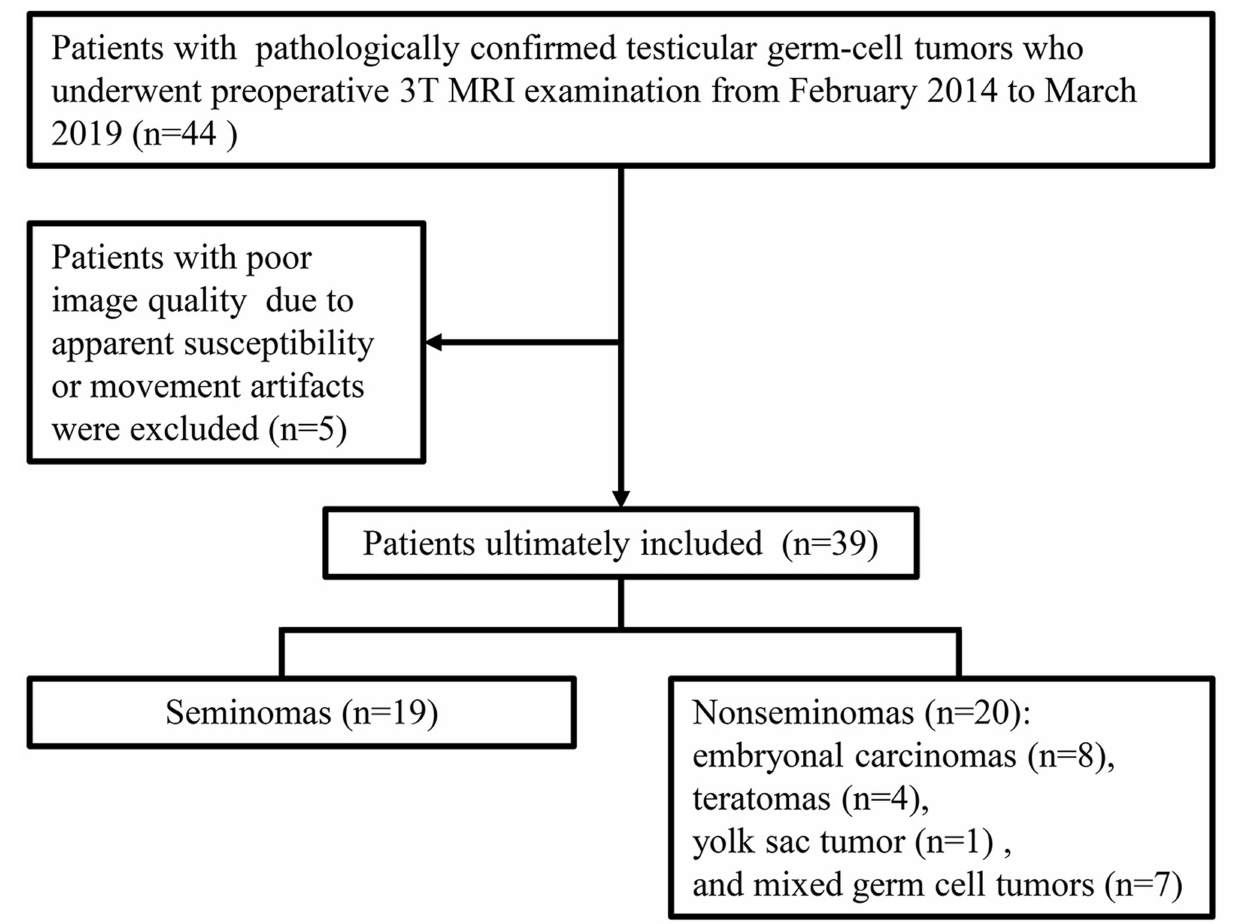
FIGURE 1 | Flow chart of patients’ inclusion and